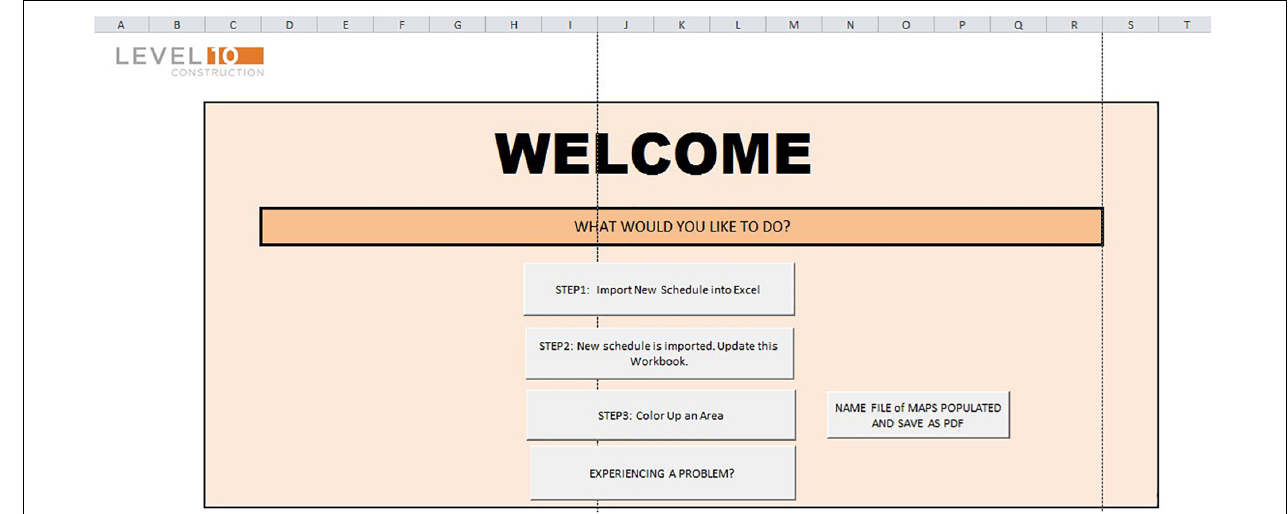
FIGURE 7 | User interface of the daily space schedule generation program for steps [4], [5], and [6].